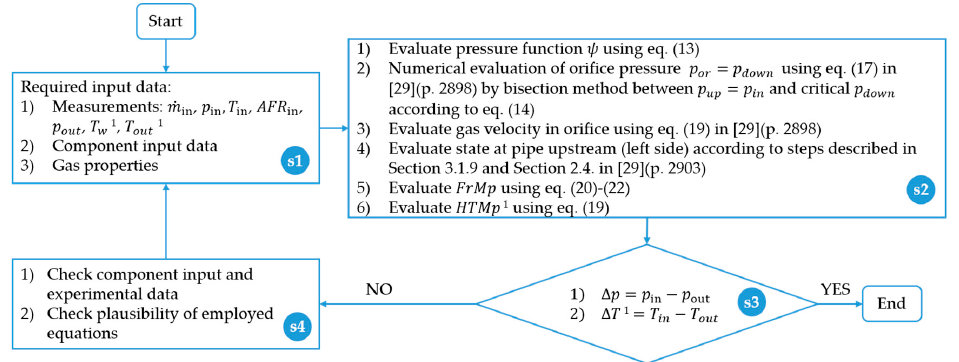
Figure 6. Flowchart of CBPs’ evaluation of the SS 1, SS 2 and SS 4 shown in Figure 2a; (cid:1865)(cid:4662) (cid:3036)(cid:3041)